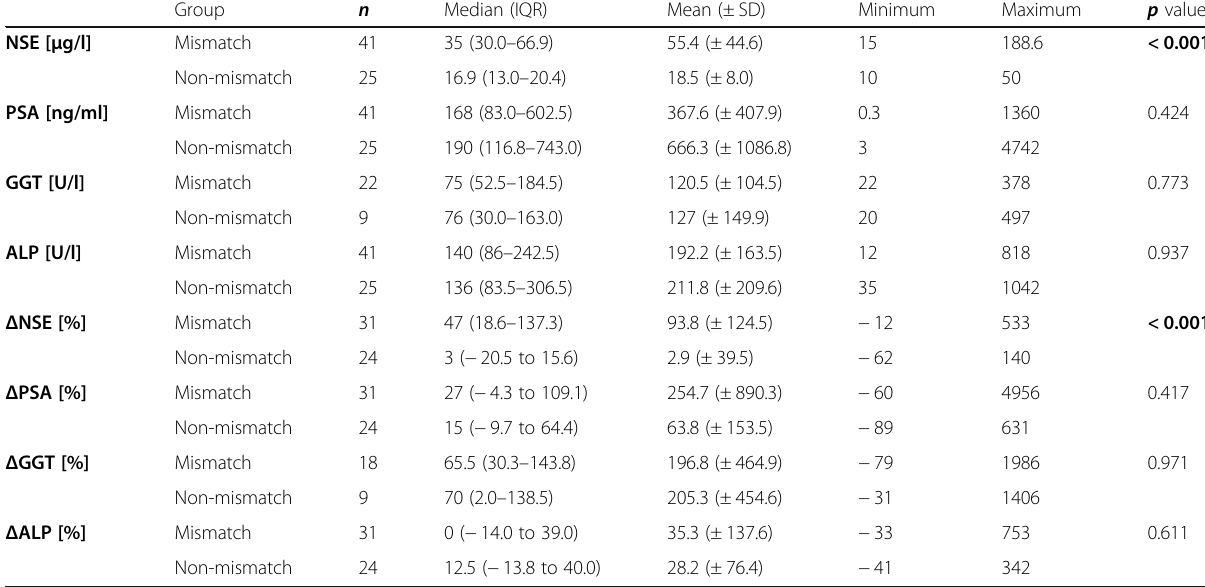
Table 2 Descriptive statistics of serum